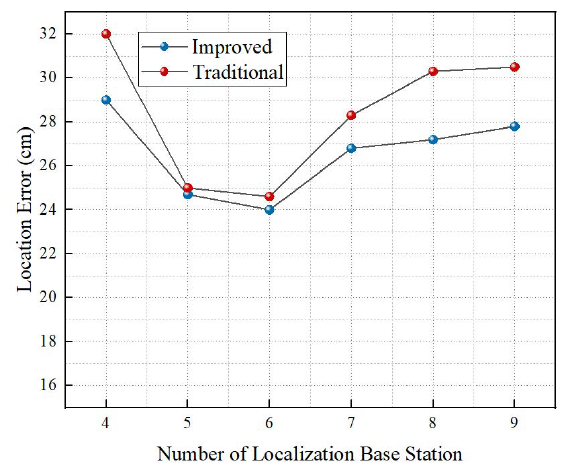
Figure 10. Impact of the number of localization base stations on localization